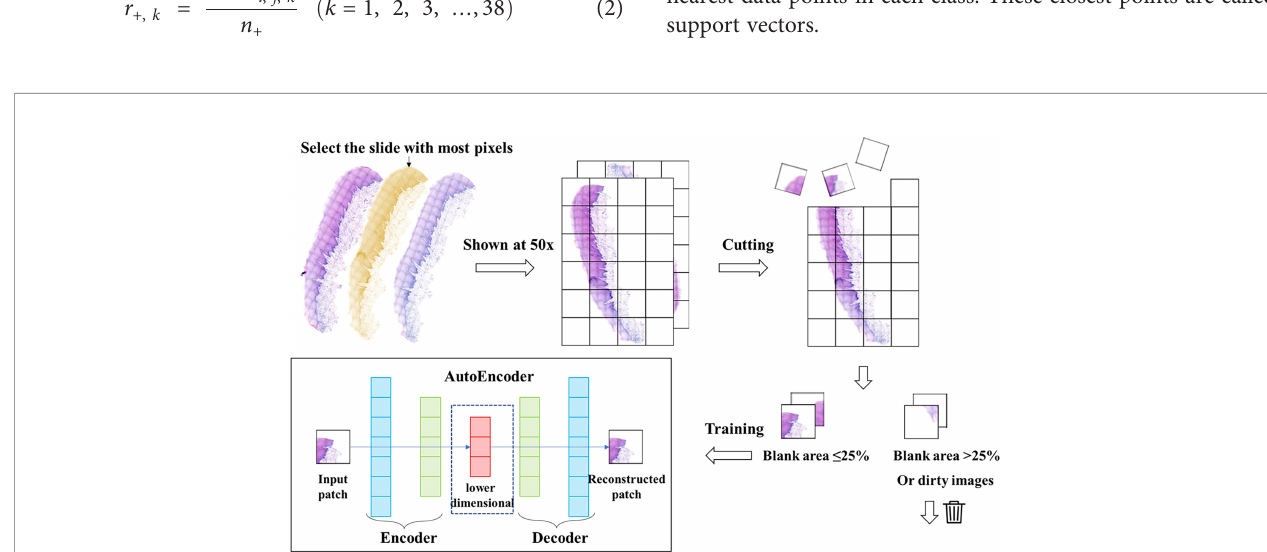
FIGURE 1 | Data processing and autoencoder construction. We selected the slide with the largest number of pixels from each patient ’ s slide and cut it into patches of 128*128 pixels. Then we fi ltered these patches to remove the patches with low quality, and then trained the autoencoder with the fi ltered patches set. The trained autoencoder can compress the image into a one-dimensional